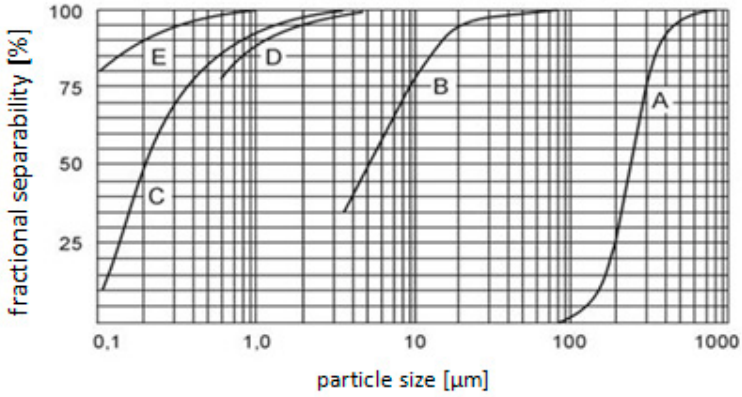
Figure 7. Fractional separation diagram of disintegrated wood mass of individual types of separation technique: A—settling chambers, B—dry mechanical separators, C—fabric filters, D—wet separators, E—electrofiltrators. Table 7. Separation limits for separation technique. Type of Separation